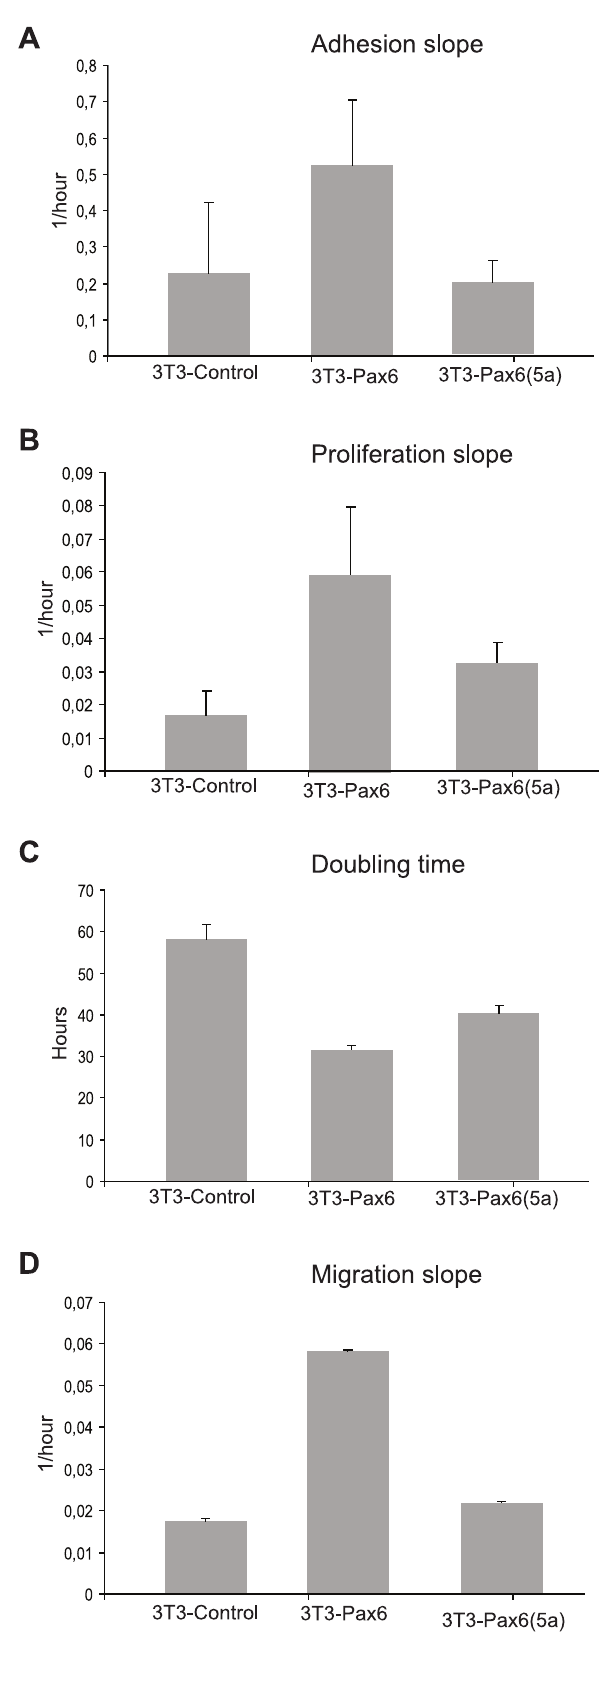
Figure 8. Pax6 expressing FlpIn-3T3 cells have higher prolif- eration and higher migration capacity compared to FlpIn-3T3 control cells and Pax6(5a) expressing cells. Control, Pax6 and Pax6(5a) cells were seeded in xCELLigence (Roche) proliferation plates, cells were left on the bench for 1 hr before the plates were put in the xCELLigence machine for measurements for 24 hrs. The measured values were used to calculate the (A) adhesion slope, (B) proliferation slope and (C) doubling time. For adhesion and proliferation slope analyses the mean and standard deviation of three independent experiments are shown. The doubling time analysis shows one representative experiment out of three, because absolute values were changing from experiment to experiment probably due to fluctuations in cell condition. However, described pattern of increased proliferation (Pax6 . Pax6(5a) . control) was consistent in all experiments. Each experiment was done in triplicates (A–C). xCELLigence migration plates were used to measure the migration, and to calculate the migration slope (D). One representative experiment out of 3 is